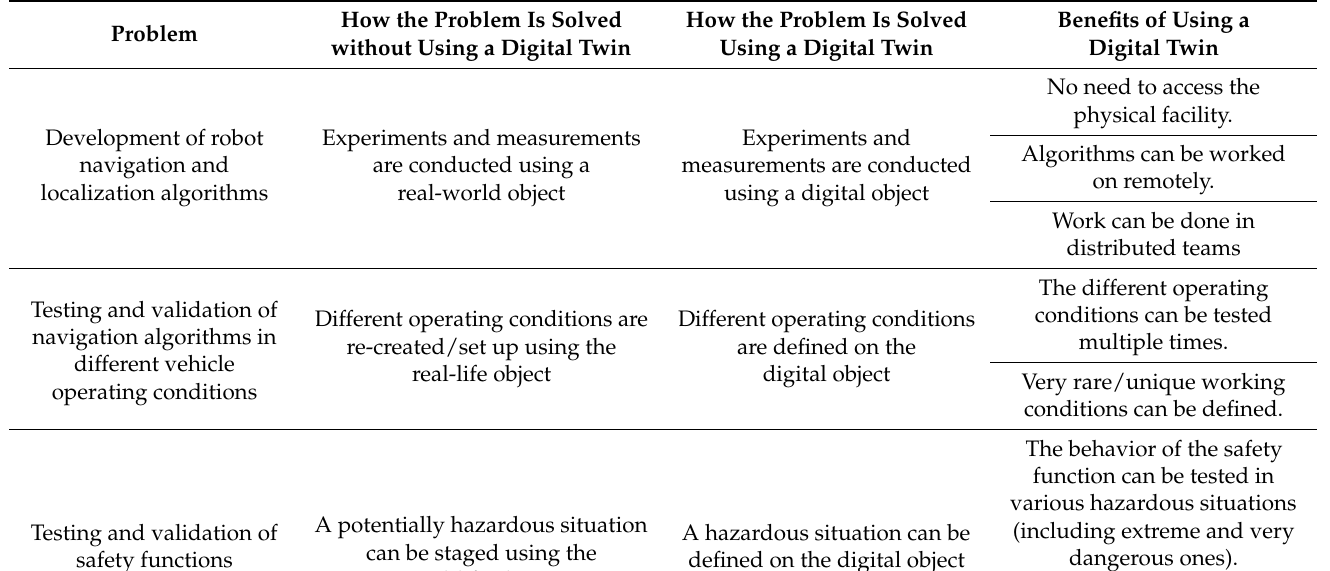
Table 1. Benefits of using digital twins of AMR/AGV and their operating